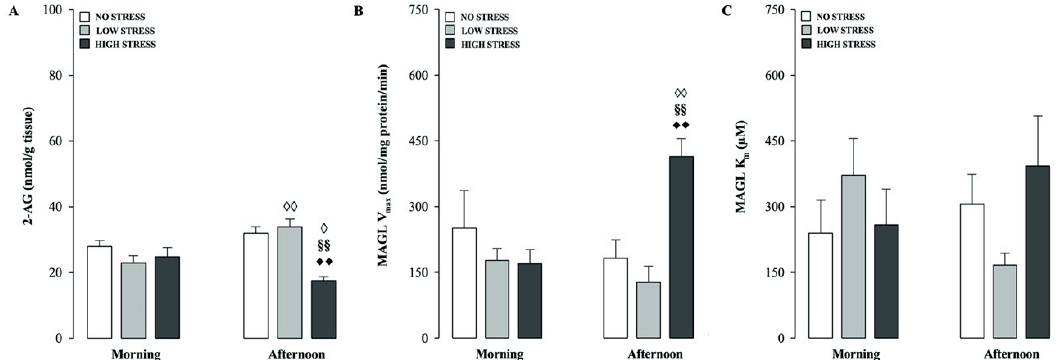
Figure 1. Time-of-day -dependent effects of stress on short-term recognition memory influence hippocampal 2-AG levels and its degradation. Hippocampal 2-AG levels ( A ), and MAGL V max ( B ) and K m ( C ) values, as assessed immediately after the testing trial in non-cannulated rats that were subjected to no, low or high stress conditions after the training trial performed in the morning or afternoon. Post hoc comparisons reported significant differences between groups as follows: ♦♦ p < 0.01 vs the corresponding no stress group. §§ p < 0.01 vs. the corresponding low stress group. ♢ p < 0.05; ♢♢ p < 0.01 vs the corresponding stress condition groups trained in the morning. Data are expressed as mean ± SEM ( n = 4–10 per group).